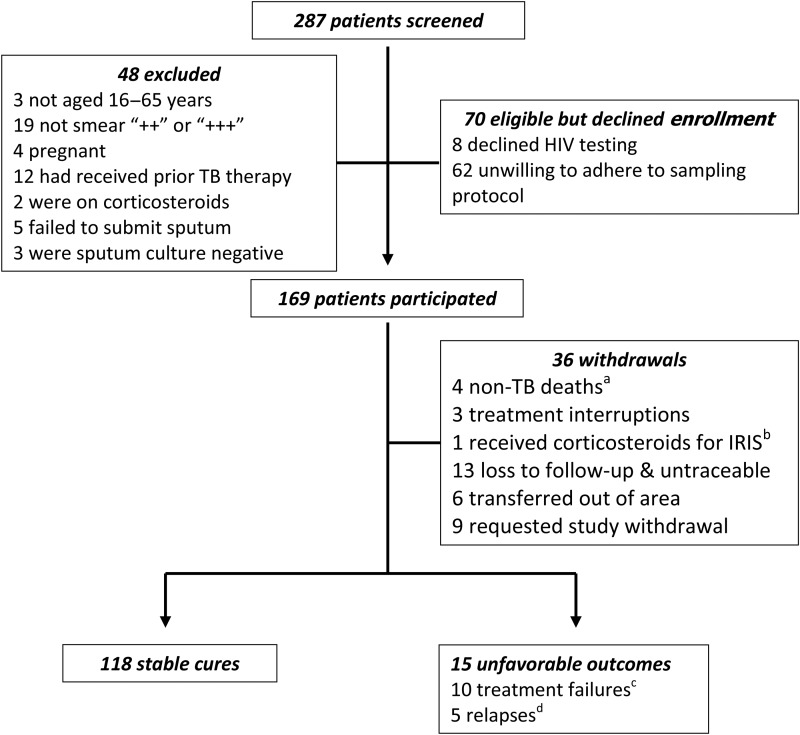
Patient screening, recruitment, and follow-up. aFour patients died after sputum smear and conversion to negative. All were human immunodeficiency virus (HIV) infected and had no ongoing symptoms of active tuberculosis (TB). As the cause of death was not attributed to TB by the study doctor or attending physician, these patients were not deemed to have reached a study endpoint and were withdrawn from the analysis; bImmune reconstitution inflammatory syndrome (IRIS); cOne patient died during the second week of therapy while still sputum smear and culture positive for Mycobacterium tuberculosis. The cause of death was attributed as TB; dOne patient redeveloped a productive cough during posttreatment follow-up, and sputum was smear and culture positive for M. tuberculosis. The cause of death was attributed as TB.